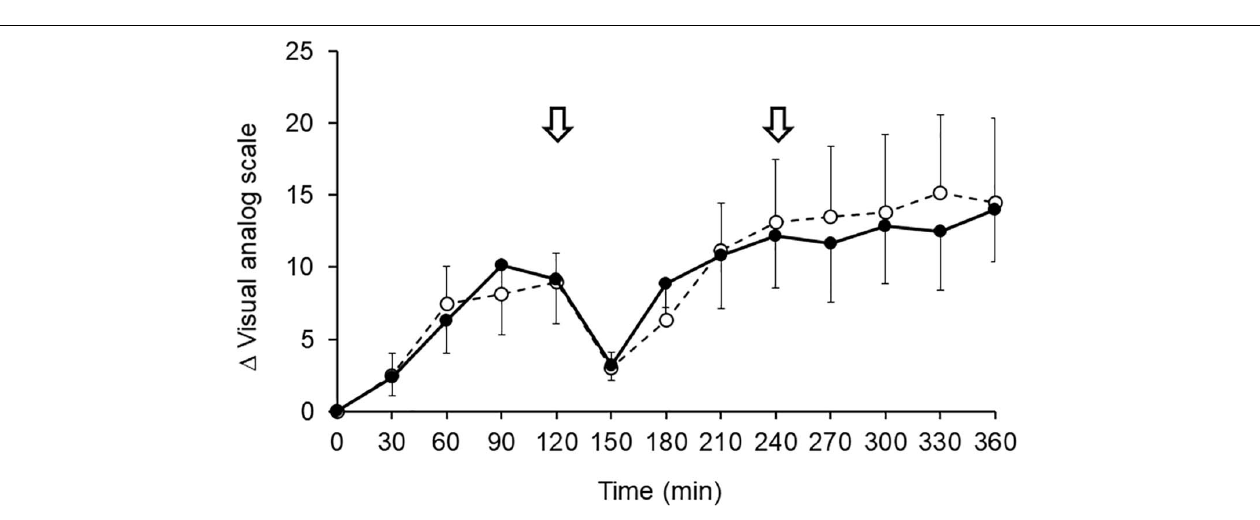
FIGURE 6 | Changes in subjective symptoms of calf swelling using VAS scale after 1,000 mg of G-Hsp ( • ) and Placebo ( ◦ ) beverage ingestion. The arrow indicates the walking for urination, mean and SE, n =